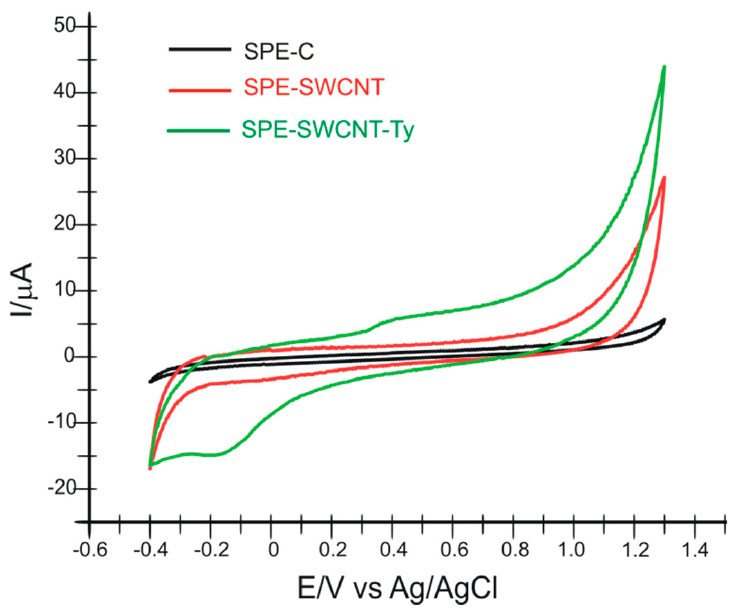
Figure 1. Cyclic voltammograms recorded by the three sensors in 10 − 1 M PBS solution, pH 7.0, scan rate 0.1 V·s − 1 .